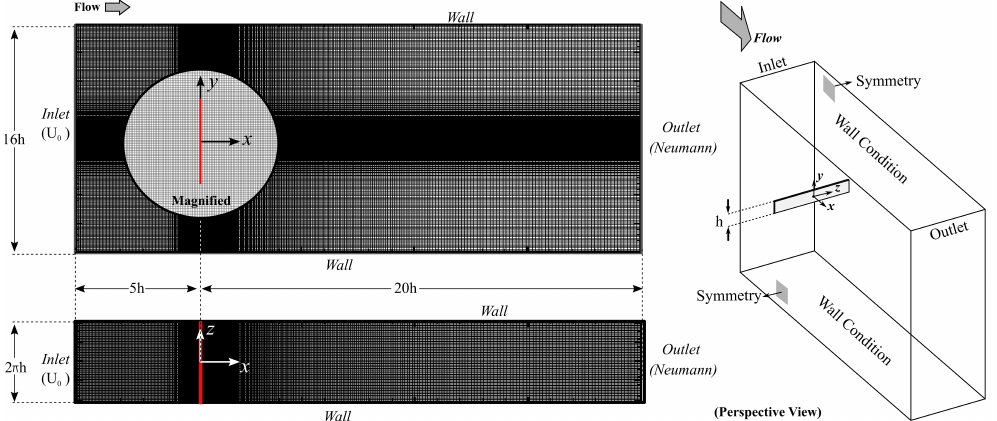
Figure 1. Schematics of the computational domain and the spatial grid (not to scale). The darker regions are the result of higher density